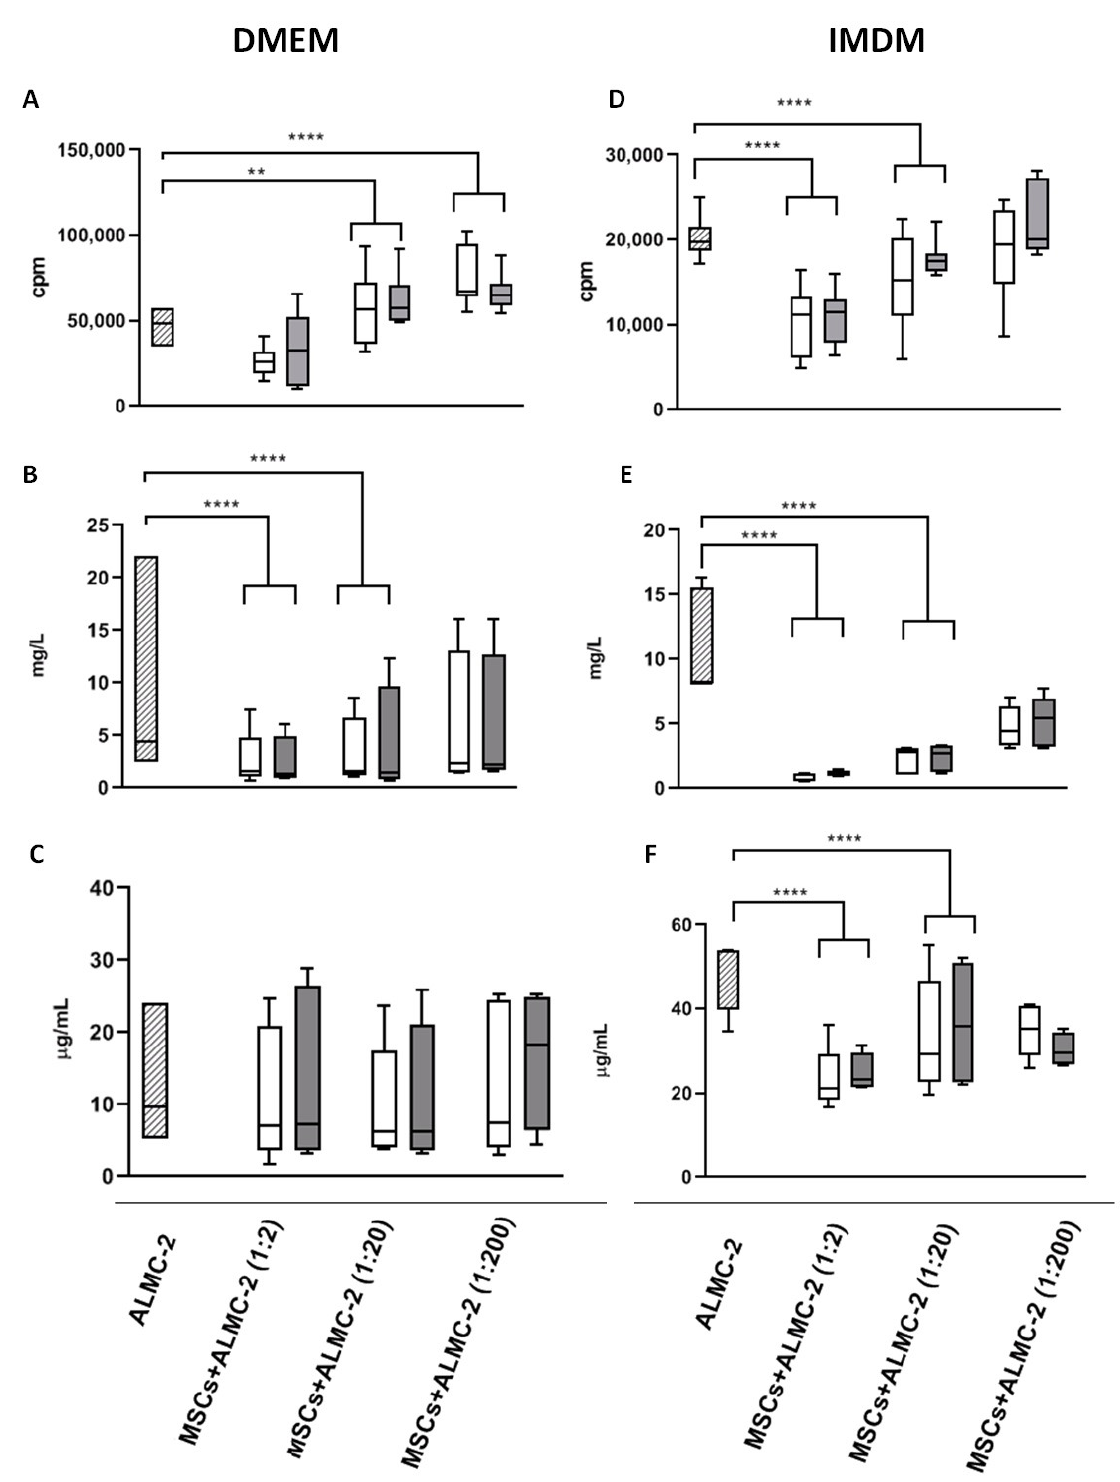
Figure 6. MSC/ALMC-2 co-culture experiments. AL-MSCs ( n = 8, white bar) and HD-MSCs ( n = 7, grey bar) were co-cultured at different ratios with the ALMC-2 cell line (dashed bar). Cultures were performed in MSC (DMEM) (left panels) or ALMC-2 (IMDM) (right panels) complete media. ALMC-2 cell proliferation, expressed as cpm for 3 H Thymidine incorporation ( A , D ). ALMC-2 λ LC secretion ( B , E ). ALMC-2 IgG secretion ( C , F ). Results are shown as median [25–75%, Min-Max]. ** p = 0.009; **** p < 0.0001